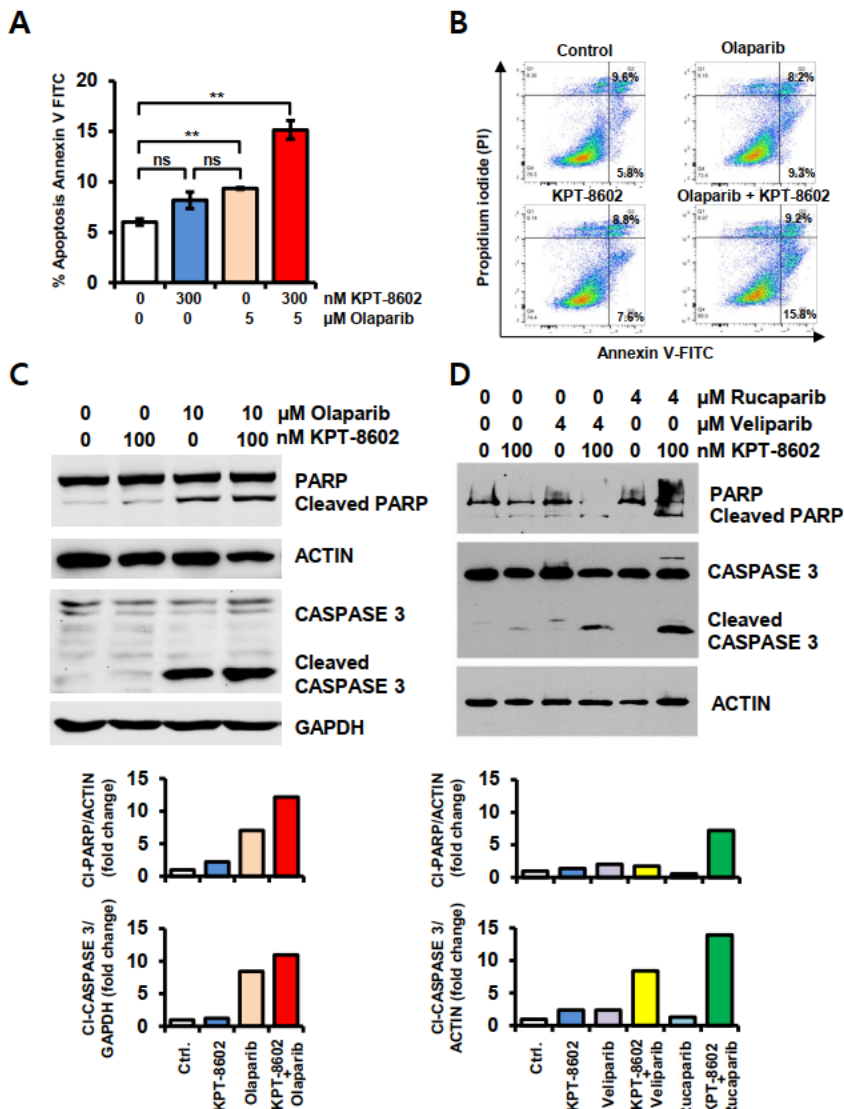
Figure 2. Apoptotic cell death with KPT-8602 and PARP inhibitors in 22rv1 cells. Apoptosis was determined by the flow cytometric detection of annexin-V and propidium iodide (PI) and western blotting technique. ( A ) Apoptosis in KPT-8602 and olaparib treated cells. ( B ) Representative flow cytometric image of KPT-8602 and olaparib-treated cells. ( C ) Western blot analysis of PARP and CASPASE 3 expression in KPT-8602 and olaparib-treated cells and ( D ) Western blot analysis of PARP and CASPASE 3 expression in KPT-8602 and veliparib- or rucaparib-treated cells. ns = not significant; ** p < 0.01. Lower panel of C and D shows relative protein expression obtained from band densities. NIH ImageJ 1.5Oi software was used to determine band density.